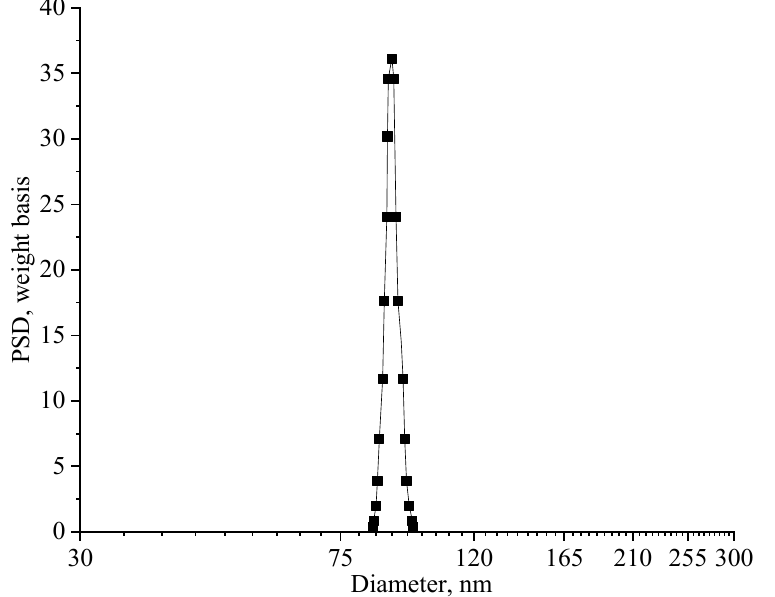
Figure 6. Histogram of SiO 2 nanoparticle size distribution.